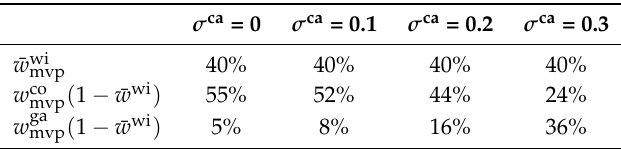
Table 3. Optimal, minimum variance system portfolios for the fully integrated wind case for ¯ w wi = 40%. σ ca = 0